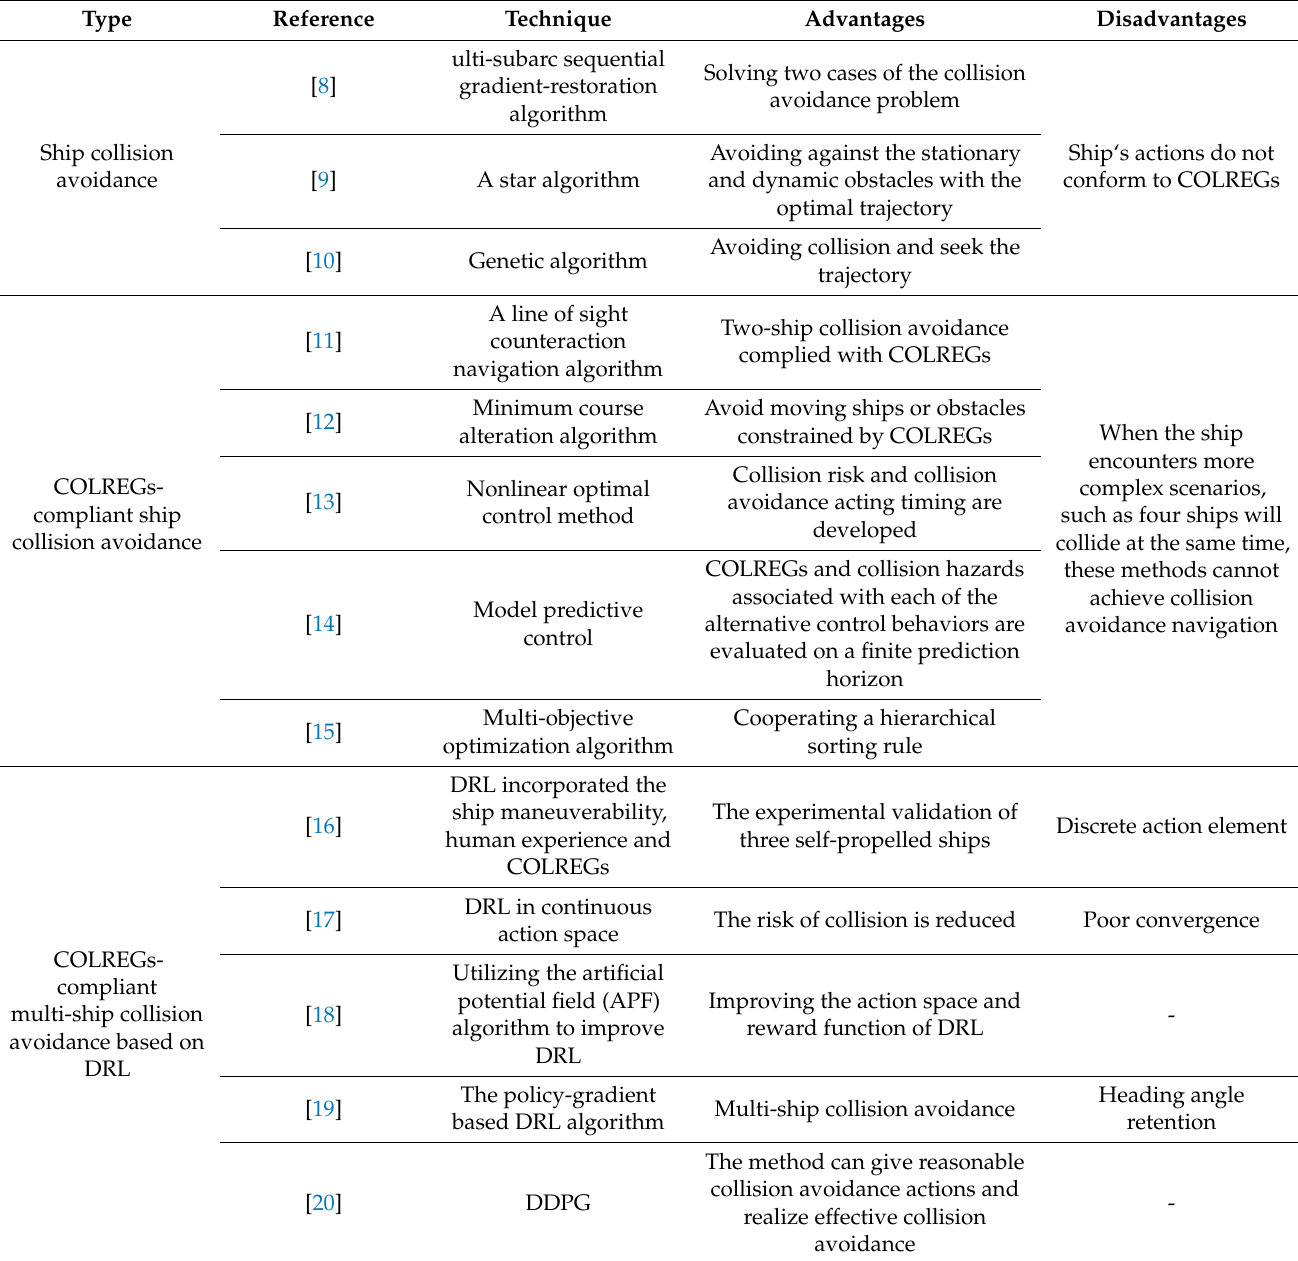
Table 1. The Simple Summary of the Literature